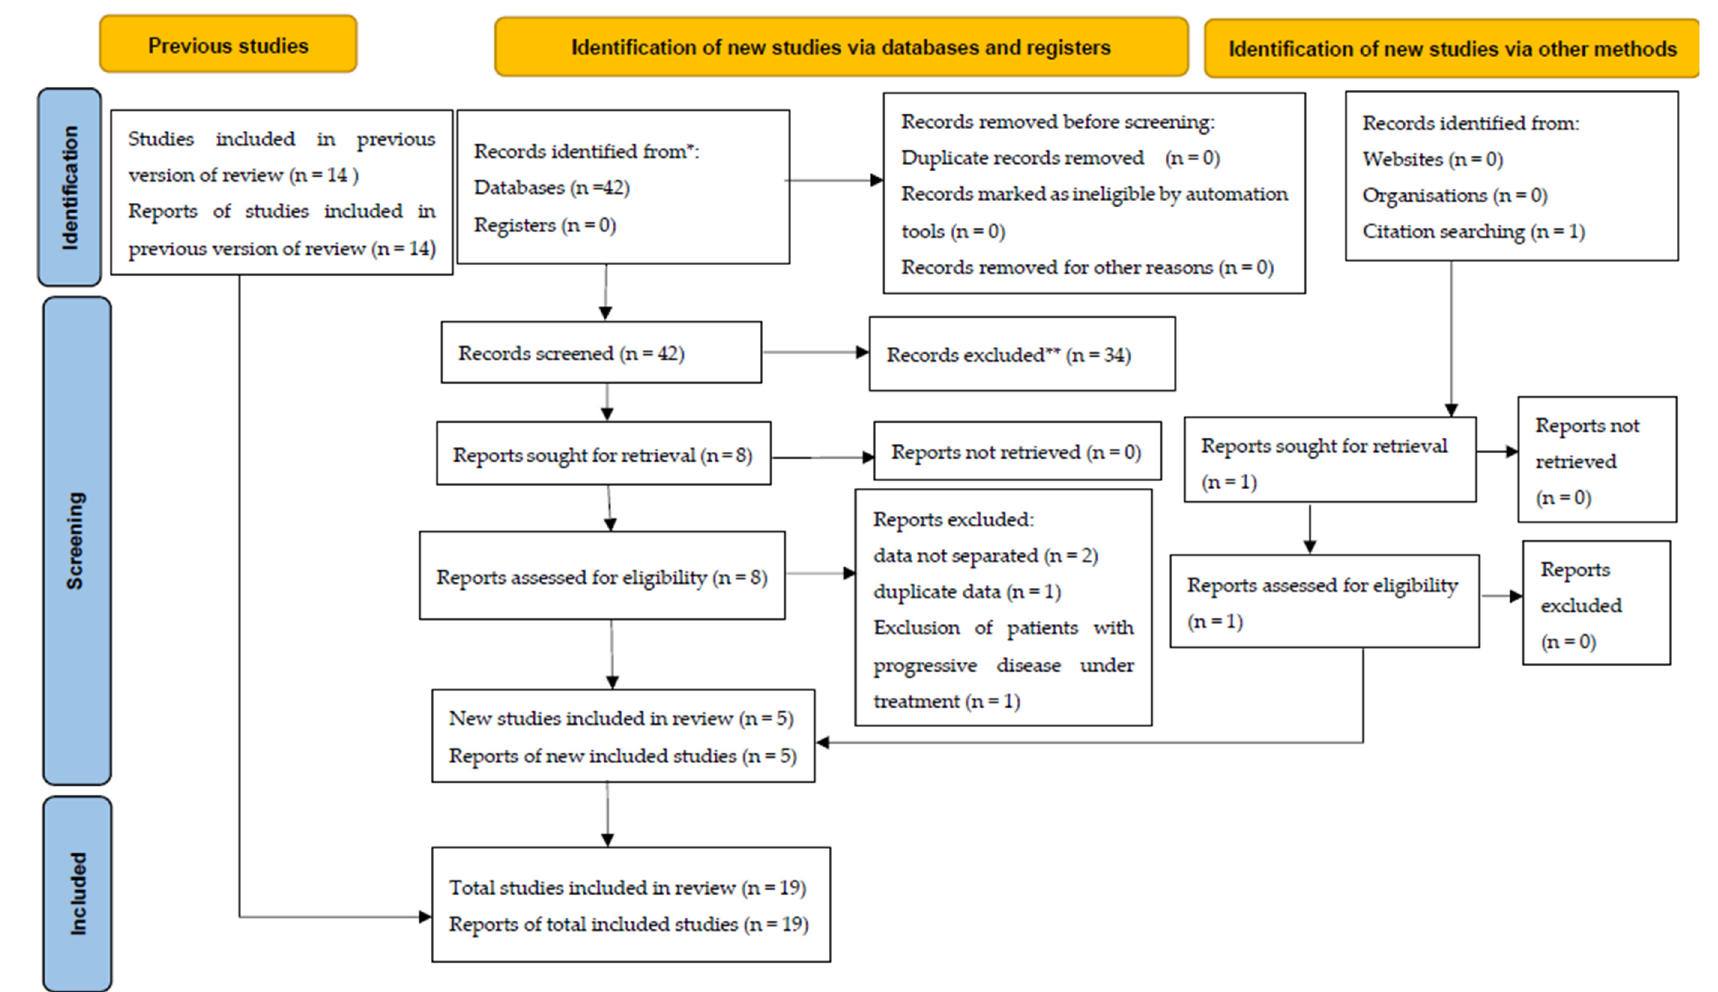
Figure 1. PRISMA 2020 flow diagram for updated systematic reviews. (*: database: Medical Subject Headings PubMed platform; **: automation tools not used for paper exclusion).